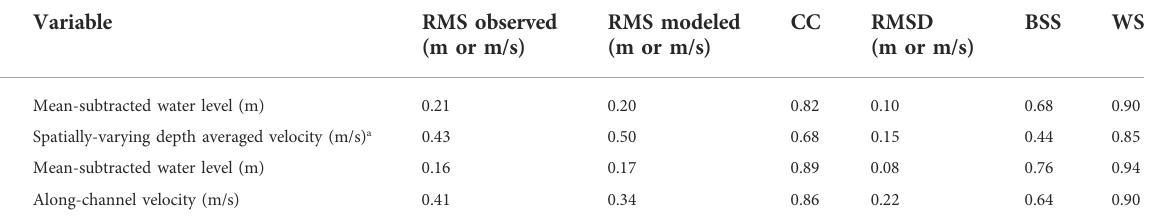
TABLE 1 Skill scores of water levels and